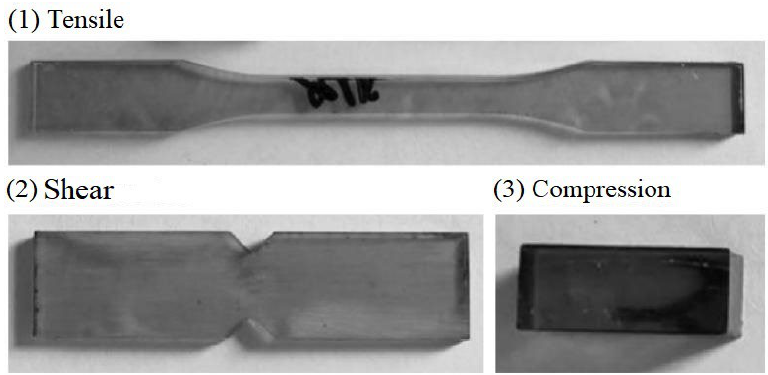
Figure 10. Test samples of cured unsaturated polyester resin. Table 3. Performance parameters of the cured 105-60RT unsaturated polyester resin.